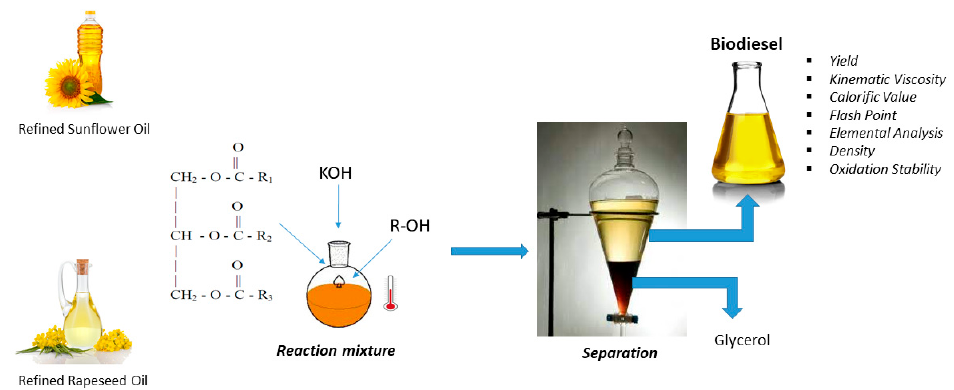
Figure 1. Schematic illustration of the biodiesel production process by transesterification and the parameters for the process and biodiesel characterization. KOH (potassium oxide); R-OH (alcohol).